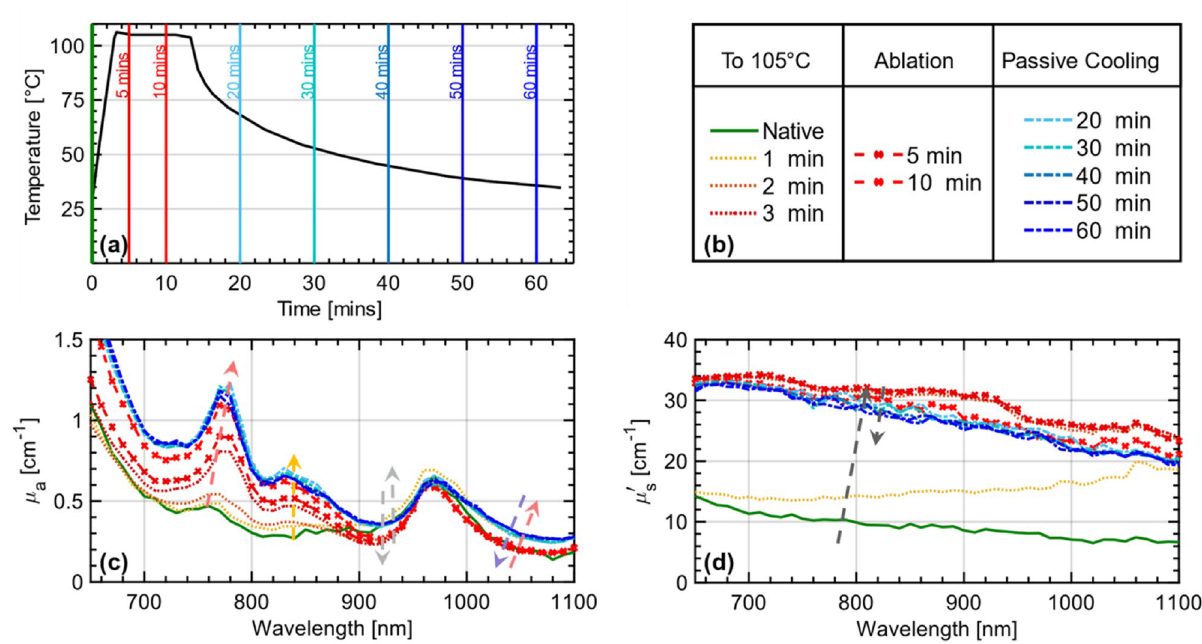
Figure 5. Reversibility of optical properties after cooling down of the ablated bovine heart tissue: ( a ) Average electrode temperature measured inside the heated volume, during the heating-up, ten-minute ablation at 105 °C, and cooling down of the bovine heart tissue. ( c ) Absorption spectra and ( d ) reduced scattering coefficient spectra at the different time stamps as shown in the legend (top